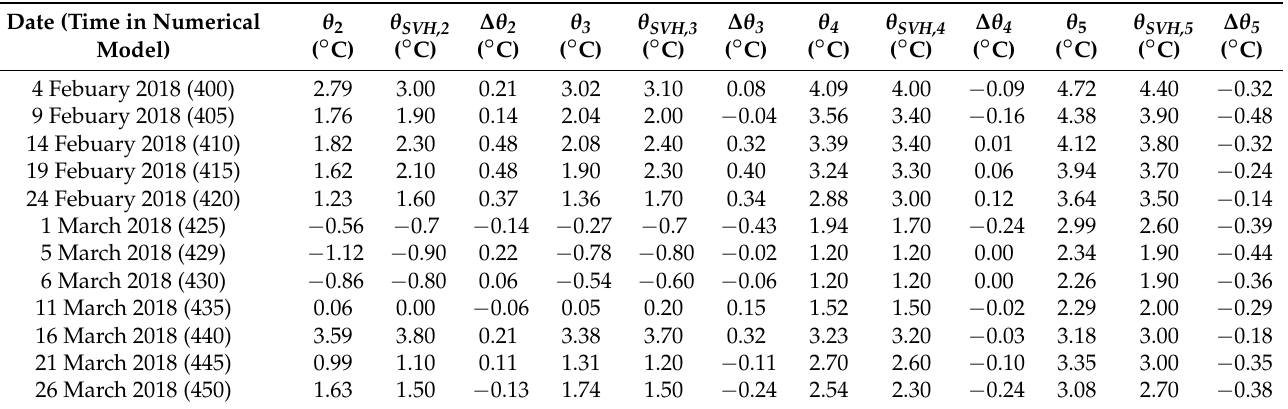
Table 5. Comparison of temperatures at the interface of individual sub-ballast layers determined by experimental and numerical